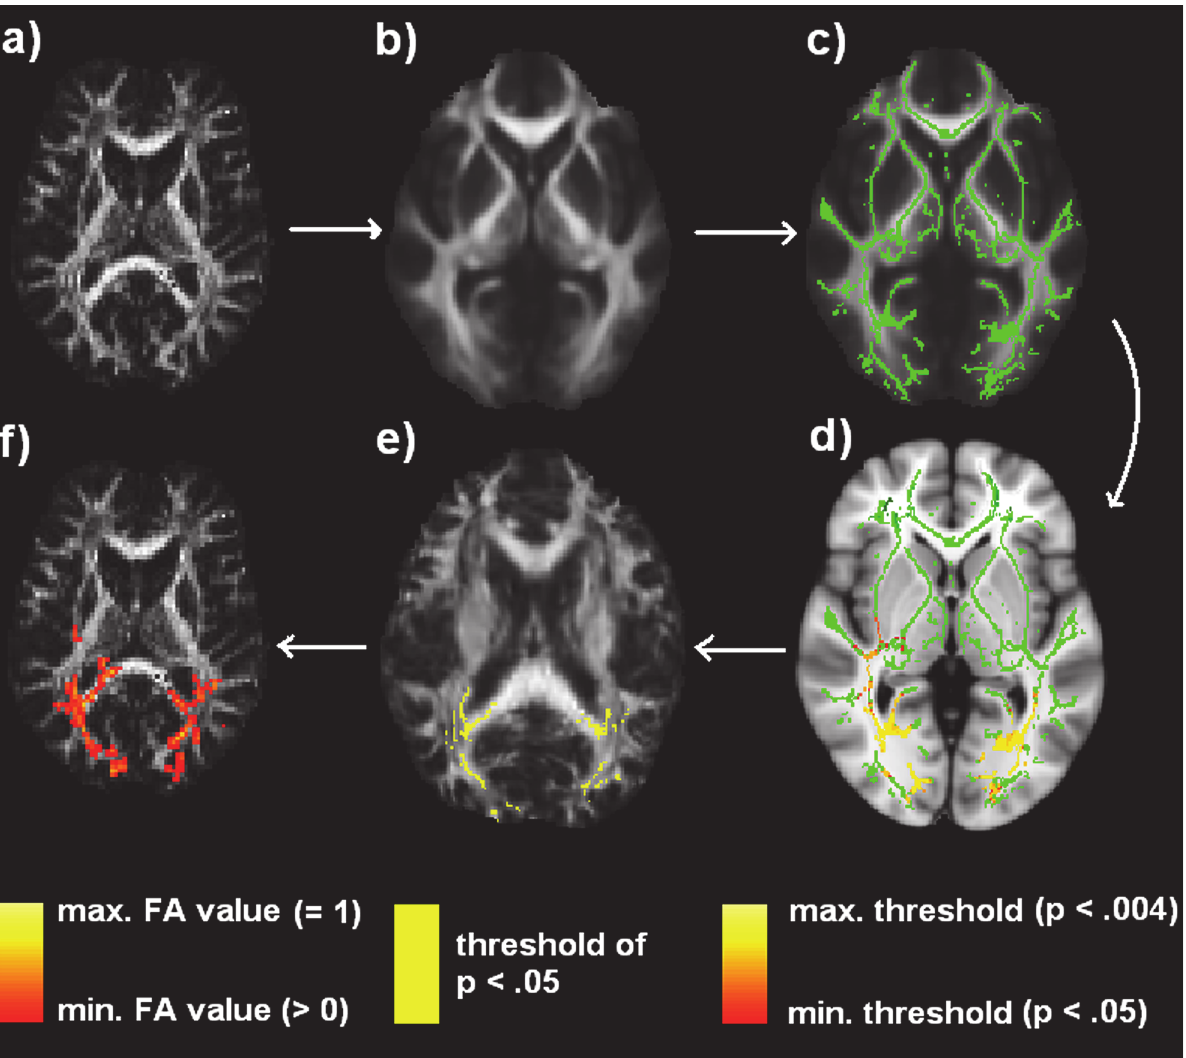
Fig 1. Analysis of the FA data using TBSS (Tract-Based spatial Statistics). a) Individual FA map in native space; b) FA maps of all subjects, transformed into standard 1×1×1 mm MNI152 space and averaged; c) skeletonization of the mean FA image; d) voxel-wise statistics on the skeletonized FA data, indicating significant group differences (yellow: p < 0.004; red: p < 0.05); e) back-projection from averaged skeleton space to each subject ’ s standard space for post hoc correlation analyses (color indicates that a given skeleton point matches the threshold of p < 0.05 derived from the correct tract center points in each subject), f) back-projection to the space of the native data in FA providing each individual ’ s exact anatomical locations that contributed to the group effects (yellow: max. FA = 1; red: min. FA > 0,